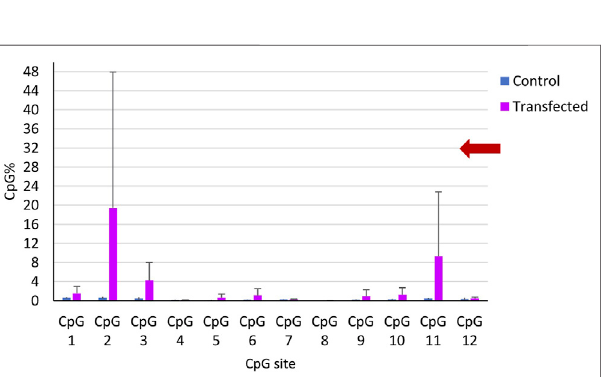
FIGURE 8 | CpG methylation percentage in the 12 CpG sites of the targeted gene along 458 bp. Mean CpG % per CpG site in all controls (blue) and in the transfected snails (magenta). The bars represent the mean CpG methylation percentage per CpG site and the error bars represent the standard error of the mean